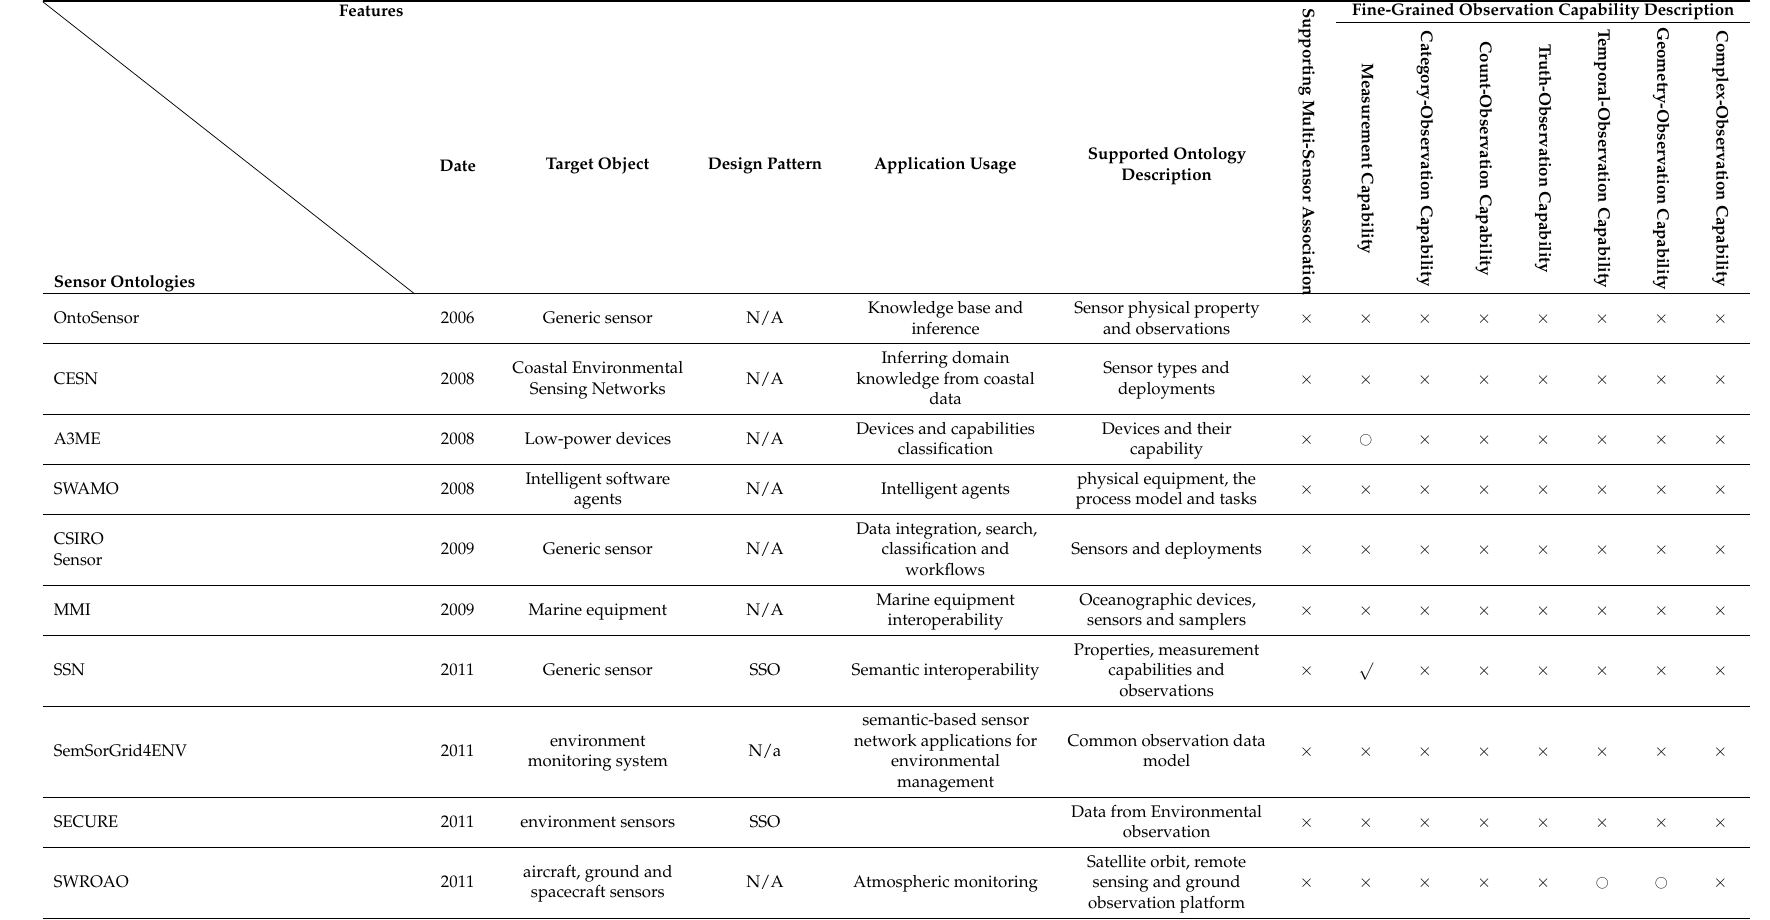
Table 1. Comparisons among current sensor